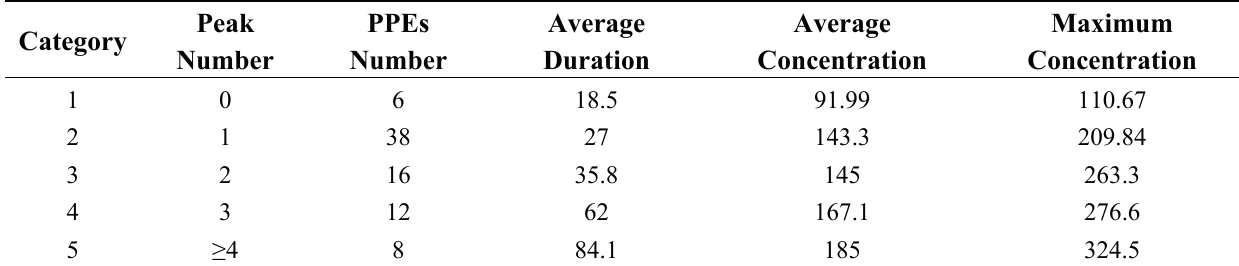
Table 6. Characteristics of evolution modes of PPEs in each